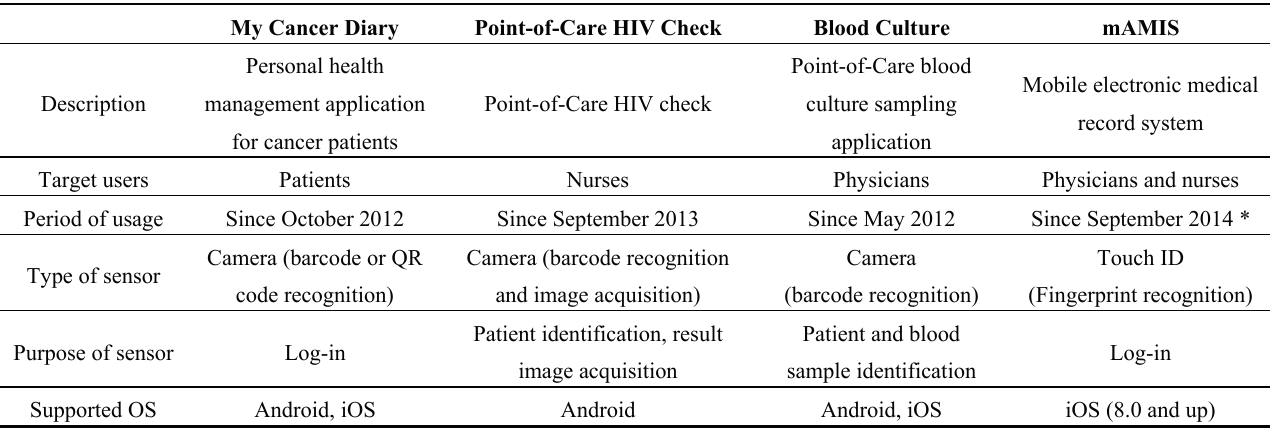
Table 1. Characteristics of the chosen